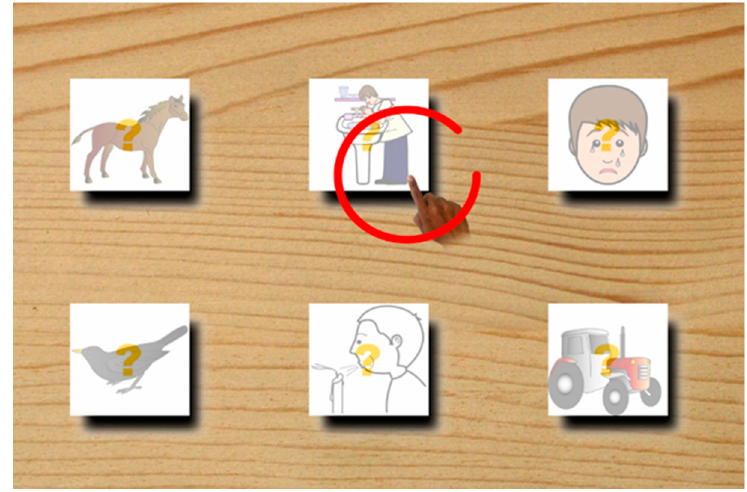
Figure 5. “Guess the tile” main panel.